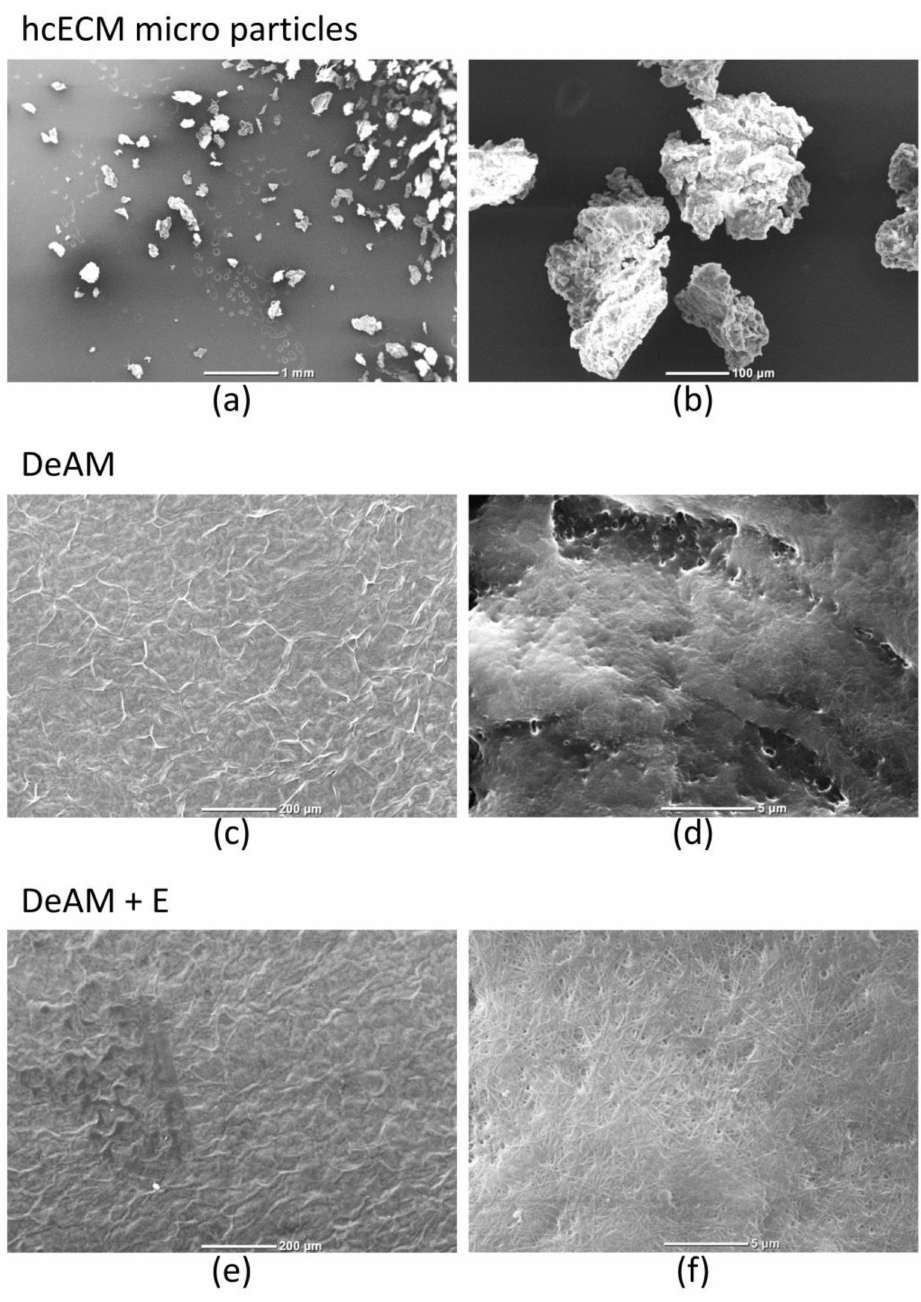
Figure 2. Scanning electron microscope visualization of hcECM microparticles as well as hgECM coated and uncoated DeAM. Structure analysis of patch components is shown as representative images. ( a , b ) SEM visualization of hcECM microparticles with a median particle feret diameter of 66 µ m [15] (( a ): magnification 20 × ; scale bar 1 mm; ( b ): magnification 170 × ; scale bar 100 µ m); ( c , d ) Structure of DeAM (( c ): magnification 100 × ; scale bar 200 µ m; ( d ): magnification 5000 × ; scale bar 5 µ m); ( e , f ) DeAM + E (( e ): magnification 100 × ; scale bar 200 µ m; ( f ): magnification 4500 × ; scale bar 5 µ